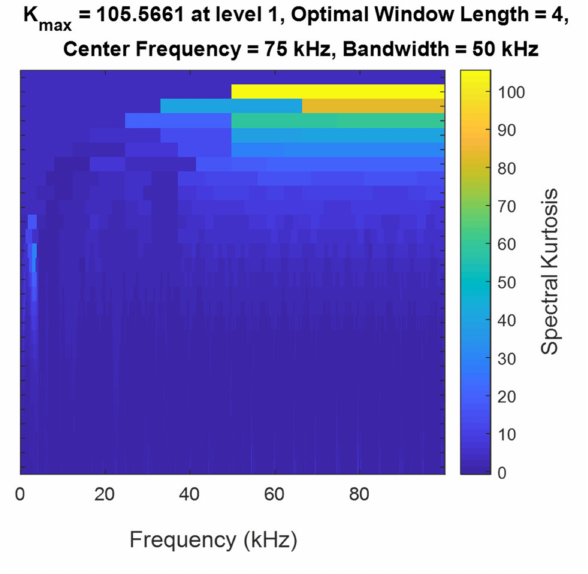
Figure 4. Kurtogram of the faulty bearing vibration signal.